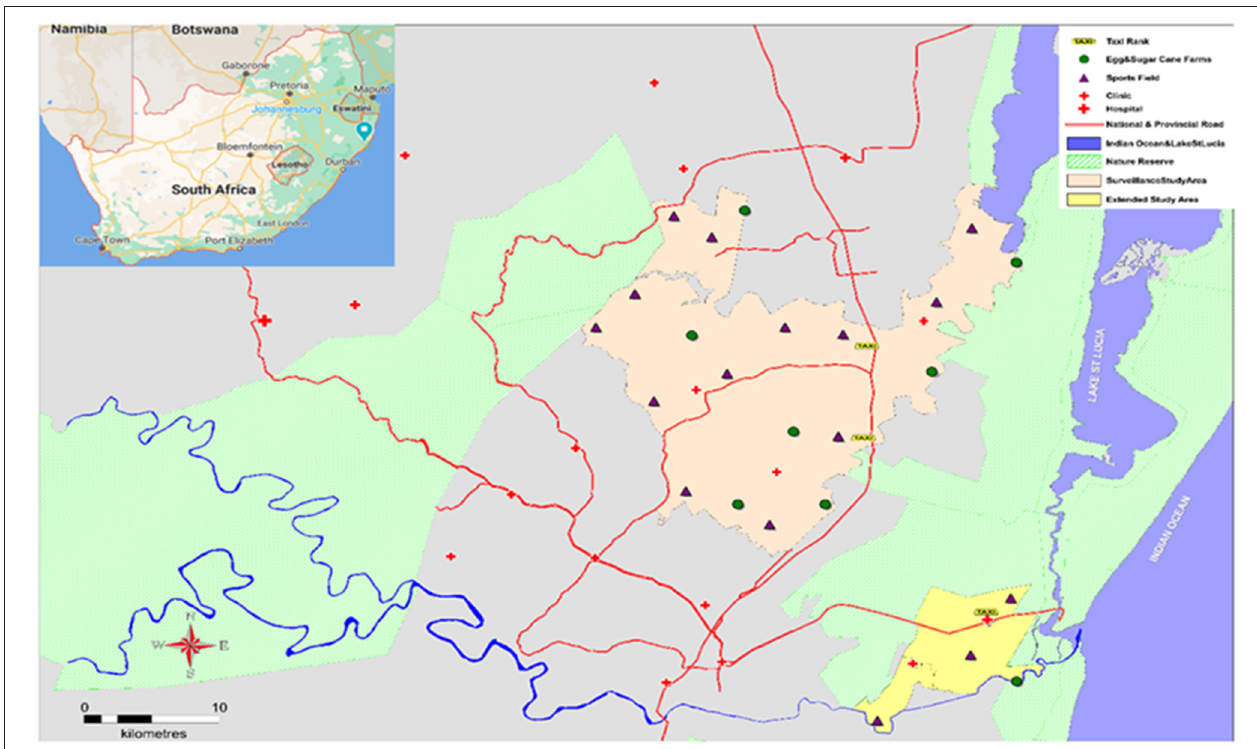
FIGURE 1 | Study area with HIVST kit distribution